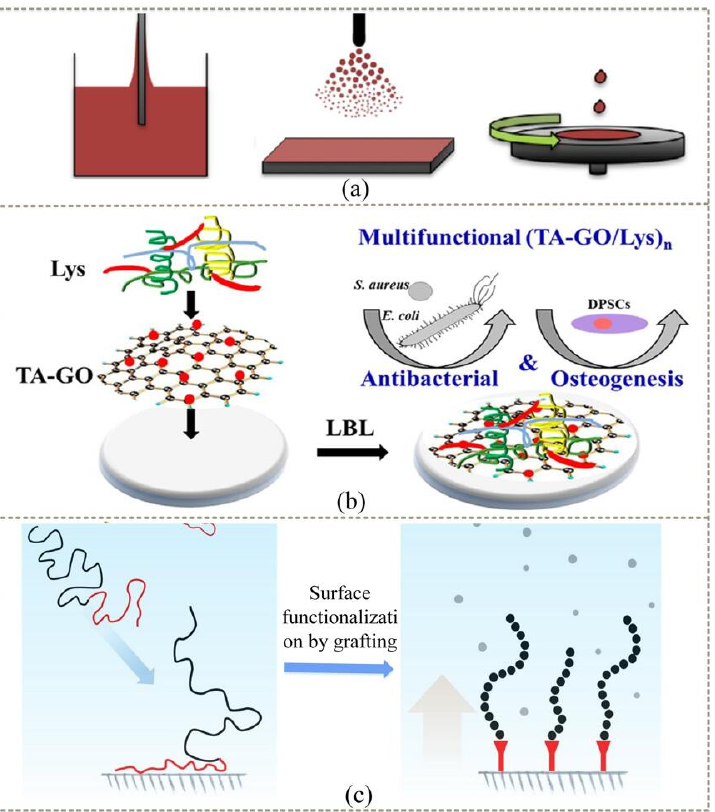
Figure 7. Different methods of attaching antibacterial coatings to material surfaces: ( a ) infiltrate, spray, and rotate [93]; ( b ) layer-by-layer self-assembly [94]; ( c ) surface grafting [95].